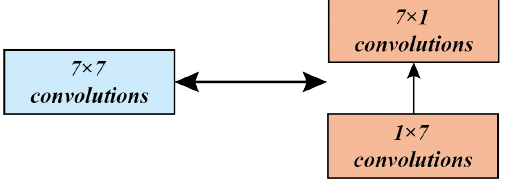
Figure 2. Inception V3’s improvements to Inception